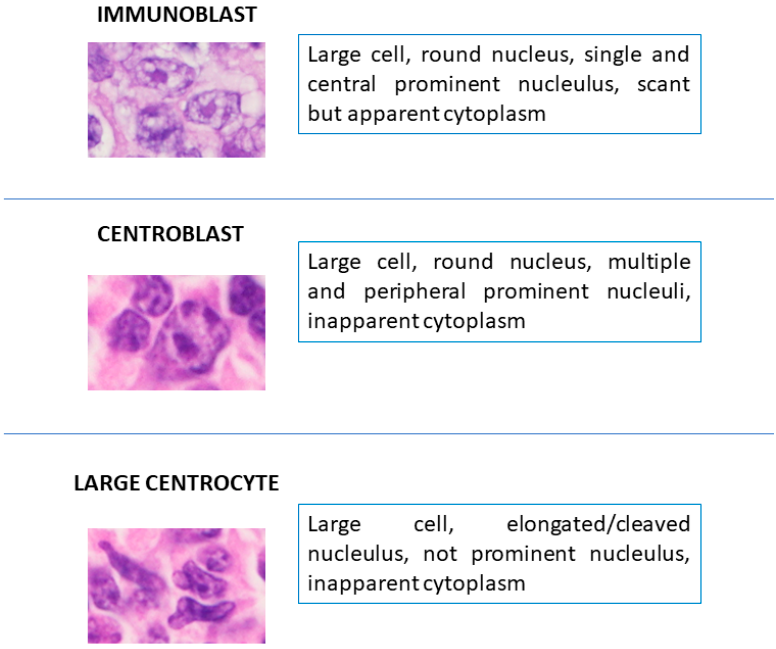
Figure 1. Most common cytotypes in primary cutaneous B-cell lymphomas with large cell morphology (hematoxylin and eosin stain, original magnification 650×).